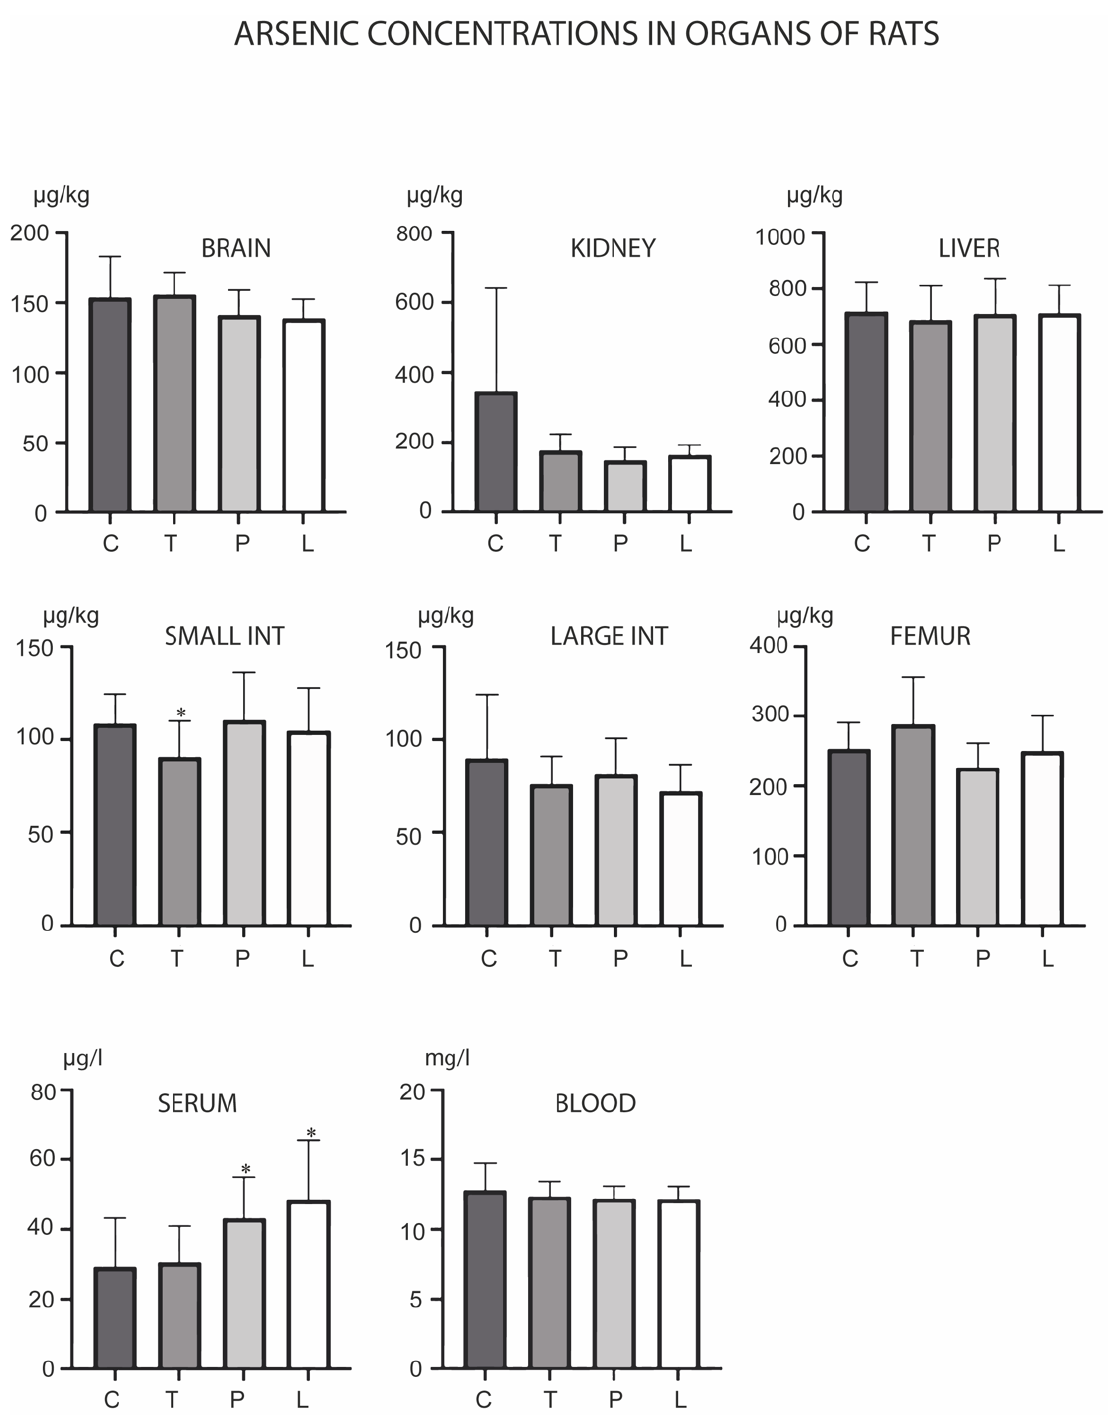
Figure 2. Concentrations of arsenic in the brain, kidney, liver, small intestine, large intestine, serum, blood and femur after the three-month oral administration of silicates. C denotes the control group; T denotes the experimental group receiving TMAZ; P denotes the experimental group receiving PMA; and L denotes the experimental group receiving Ludox silica. Asterisk (*) denotes significant differences between the experimental groups, with control at p < 0.05.